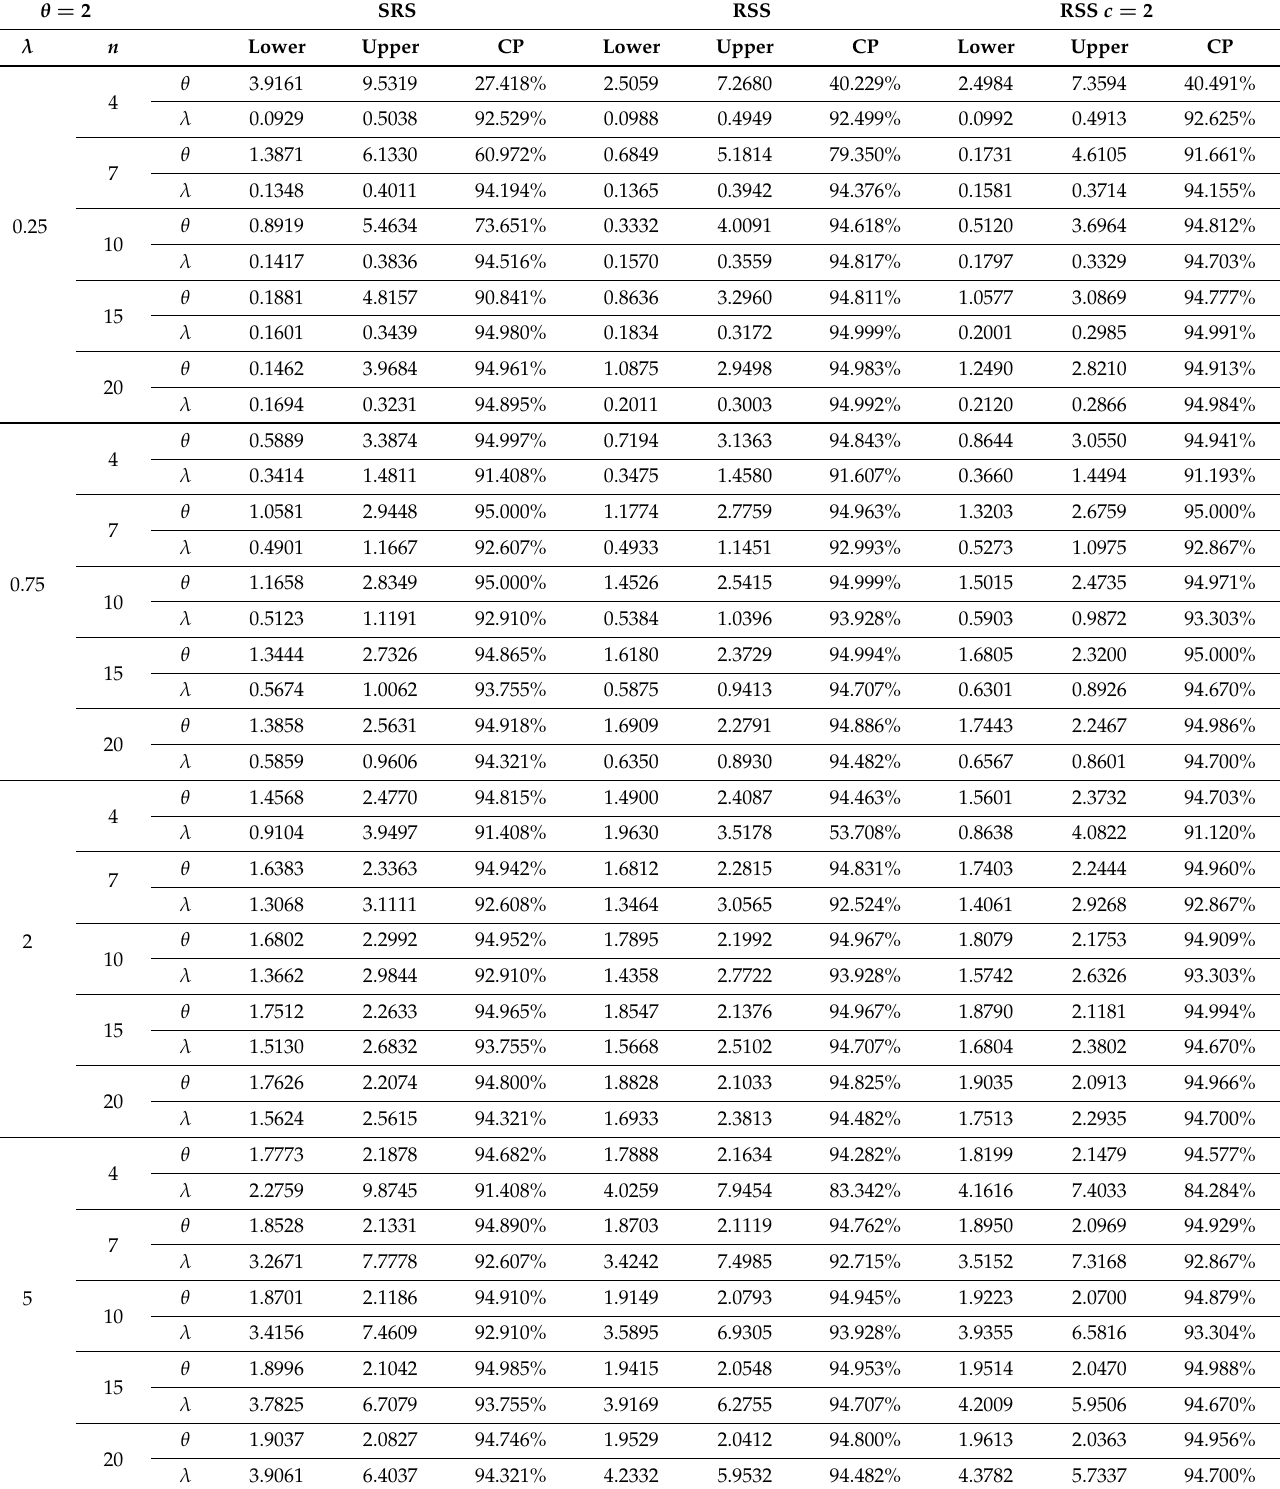
Table 8. Lower, upper bounds of CI and CP for the GB( θ , λ ) distribution under the SRS and RSS schemes when θ =